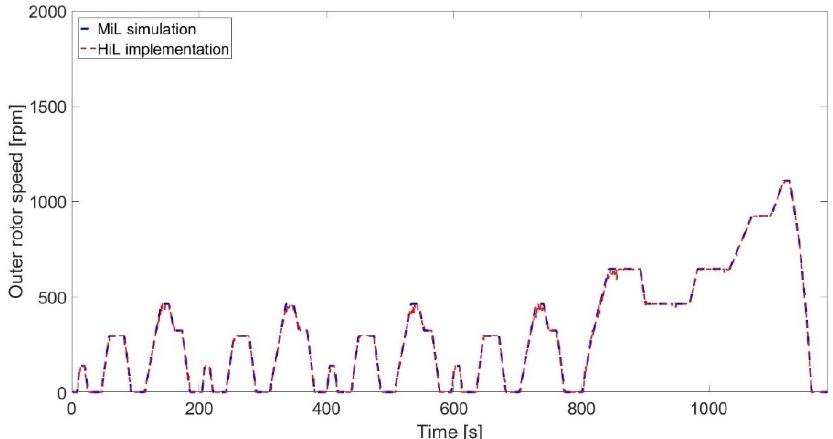
Figure 21. HiL (experimental) vs. MiL agreement results for the outer rotor speed, ECMS-based EMS.